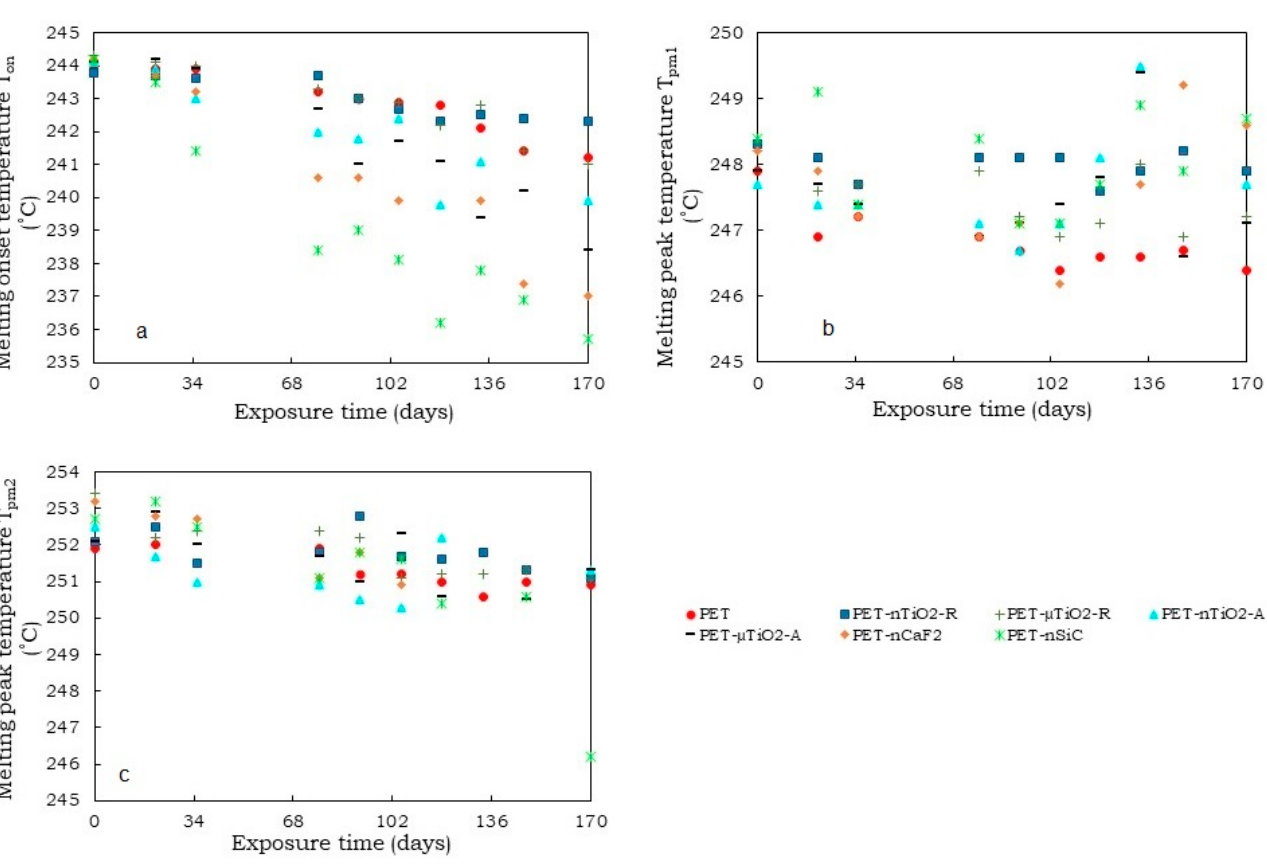
Figure 6. Variation in temperatures as a function of the exposure time (1st heating): ( a ) melting onset temperature (T on ), ( b ) melting peak temperature (T pm1 ), and ( c ) melting peak temperature (T pm2 ).